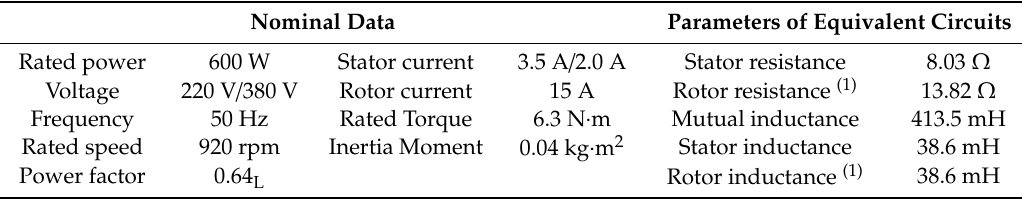
Table 1. Nominal data and parameters of induction machine type